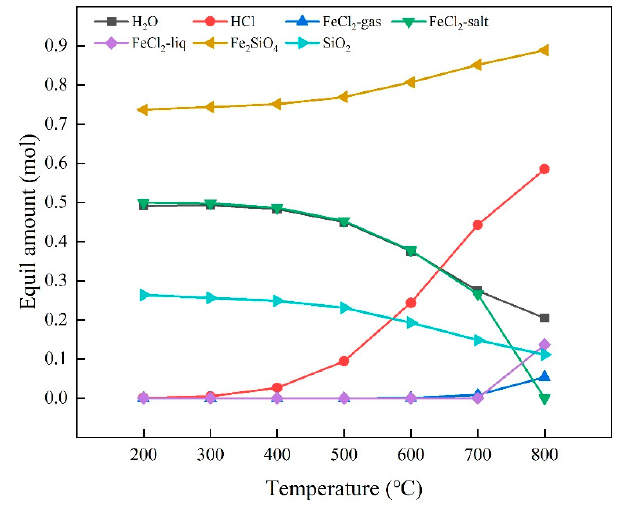
Figure 3. Changes in the content of each substance in the reaction of Fe 2 SiO 4 with HCl at different temperatures.